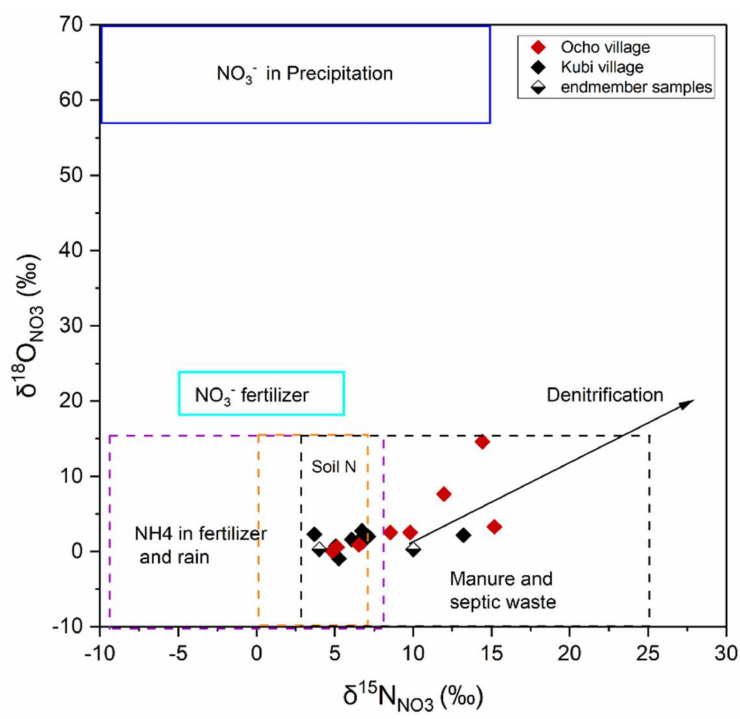
Figure 7. Nitrate isotopic signatures for sampling points in Kubi and Ocho with typical nitrate endmembers (adapted from Kendall et al.